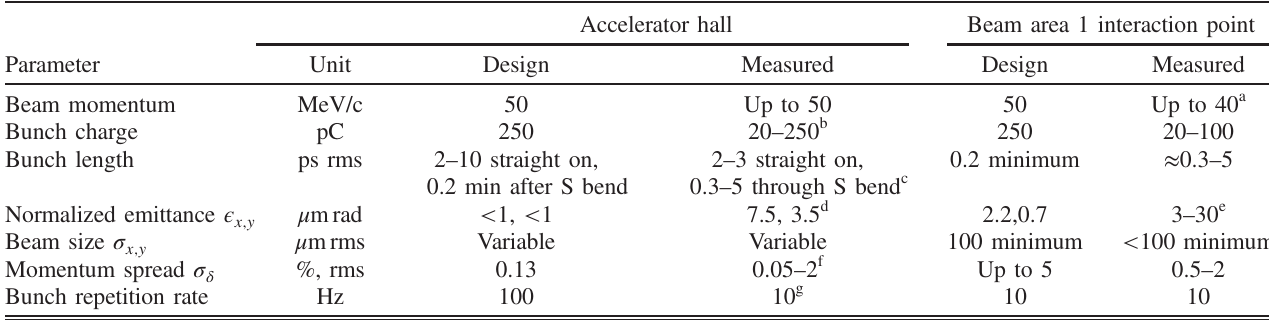
TABLE I. CLARA FE design and measured beam